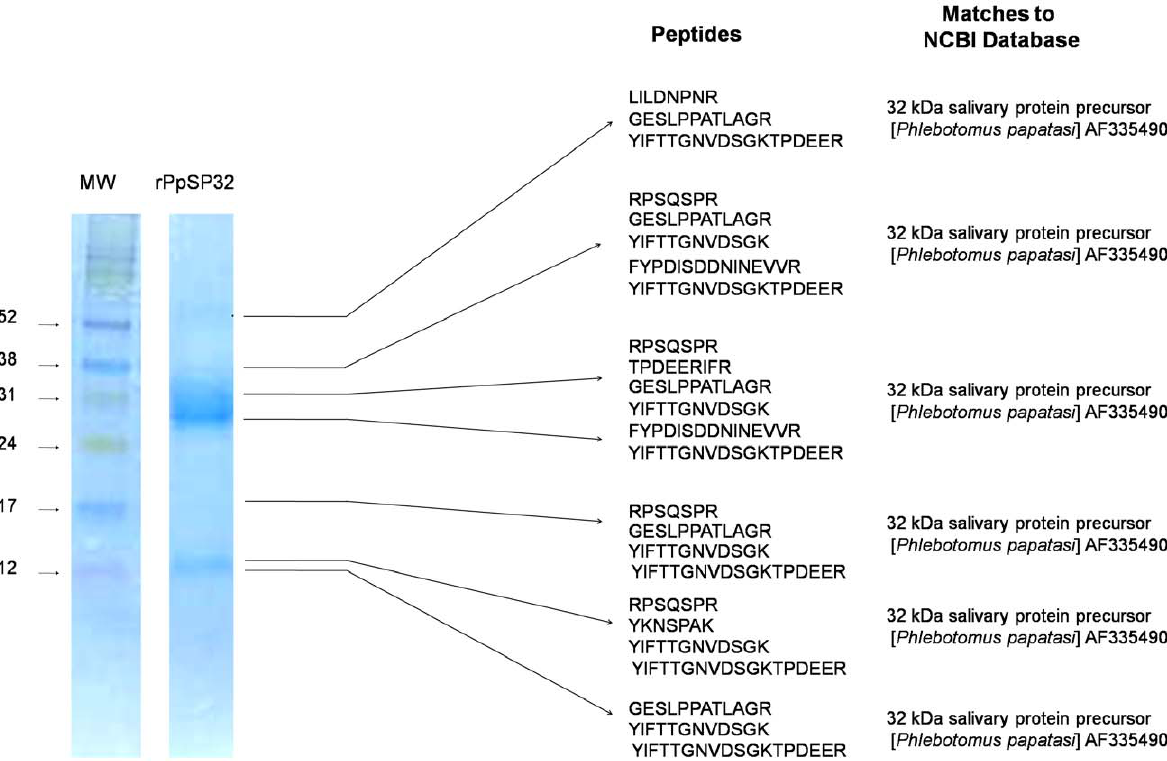
PLOS Neglected Tropical Diseases |